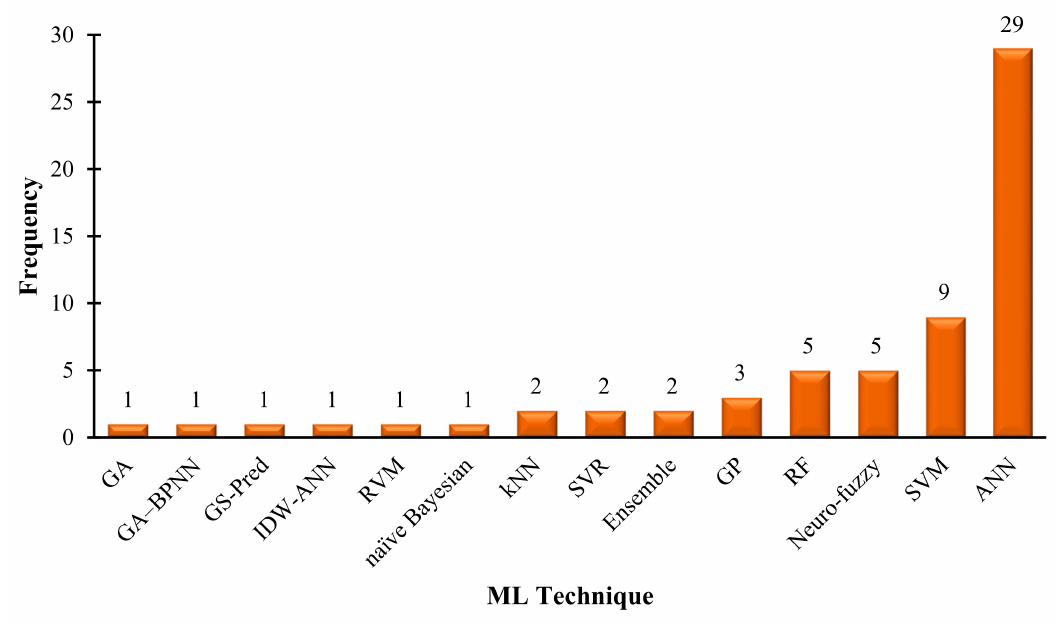
Figure 5. Distribution of machine learning techniques for mineral resource estimation.